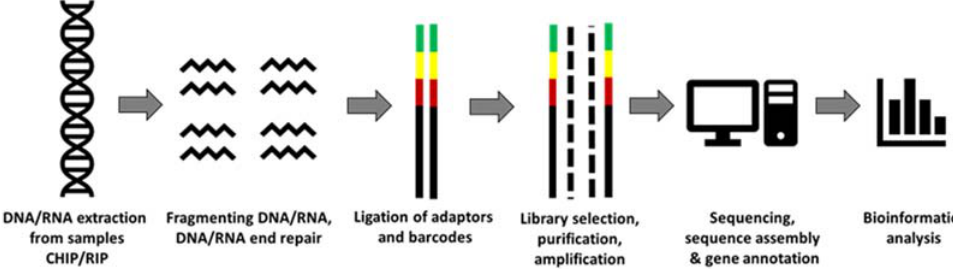
Figure 1. Basic next-generation sequencing (NGS) workflow adapted from Reference [25].